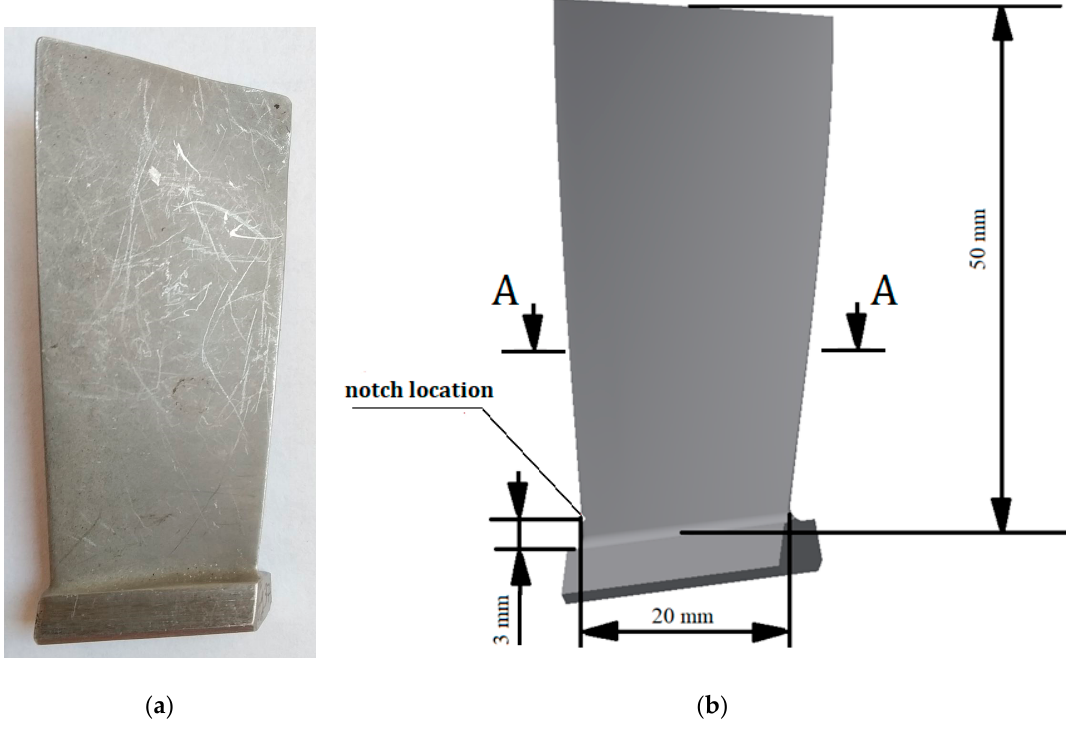
Figure 1. View of the ( a ) examined blade and ( b ) geometrical model used in the numerical analysis.